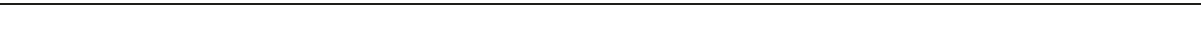
Fig. 5 p62 regulates turnover of FUS and splicing of its targets. a Western blot of symmetrically dimethylated arginines in FUS immunoprecipitates from HEK293T cells. b Left, western blot of FUS immunoprecipitates from HeLa cells treated with arsenite and Ba fi lomycin A1; Right, western blot of FUS in HeLa cells in conditions used for PLA in ( c ). c Left, PLA of p62 and wild type or indicated FUS mutants in HeLa cells treated with arsenite and Ba fi lomycin A1; Right, quanti fi cation of PLA; images counted (>10 cells/image): wild type (11), R218K (9), R216C (8), R216C + R217K (8), R521G (9), R521H (9) ( n = 3, mean ± SD, Student ’ s t -test). d Quanti fi cation of nuclear/cytoplasmic distribution of wild type and mutant FUS by fl uorescence intensity in HeLa cells treated with arsenite and Ba fi lomycin A1; cells counted: wild type (32), R218K (19), R216C (8), R216C + R218K (16), R521G (31), R521H (21) (mean ± SD, Student ’ s t -test). e Left, western blot of FUS wild type, indicated mutants and LC3 upon Ba fi lomycin A1 treatment of HeLa cells; Right, quanti fi cation of western blots normalized to Tubulin ( n = 6, mean ± SD, Student ’ s t -test). f Left, percentage of cells containing SGs in primary motor neuron cultures of wild type and p62 − / − mice ( n = 2 – 4); 35 – 150 cells were counted per condition (mean ± SD, Student ’ s t -test); Right, representative images. g Western blot of lysates from wild type (WT) and p62 − / − (KO) mice. h – l RT-PCR analysis of Zcchc6 splice variants in ( h ) p62 depleted MN1 cells ( n = 4), i indicated tissues of WT and p62 − / − mice ( n = 3), j FUS depleted and overexpressing MN1 cells ( n = 4), k FUS and p62 depleted MN1 cells ( n = 3), and l MN1 cells depleted of endogenous FUS with siRNA targeting FUS 3 ’ UTR and expressing FUS wild type or indicated mutants ( n = 4, mean ± SEM, Student ’ s t -test). brains. n A plot of the fraction of mRNAs putatively mis-spliced in p62 − / − brain ( y -axis) vs. the increasing signi fi cance of this (-log 10 p -value, x -axis); black line — all detected mRNAs, green line — mRNAs enriched in FUS-binding motifs, red line — only mRNAs putatively mis-spliced in p62 − / − brain. p = 0.0357 that putative mRNAs mis-spliced in p62 − / − brains are enriched in FUS-binding motifs. Scale bar = 10 µ